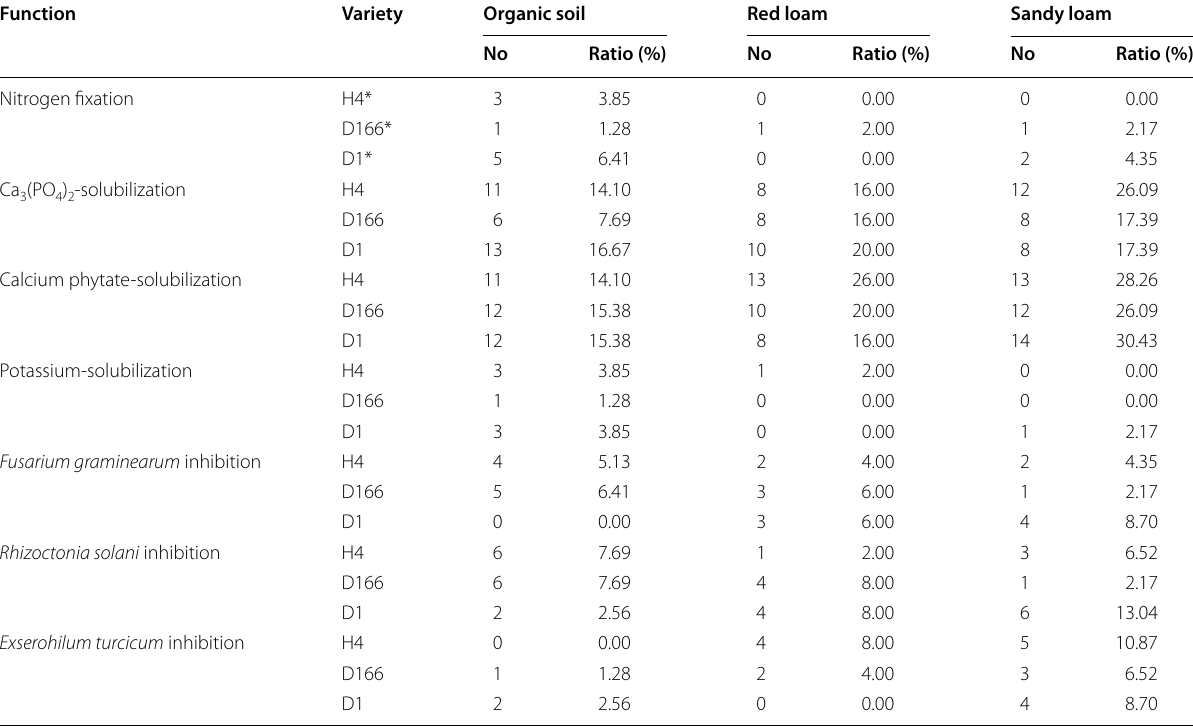
Table 3 The number of functional bacteria from roots of three maize varieties planted in three kinds of soils